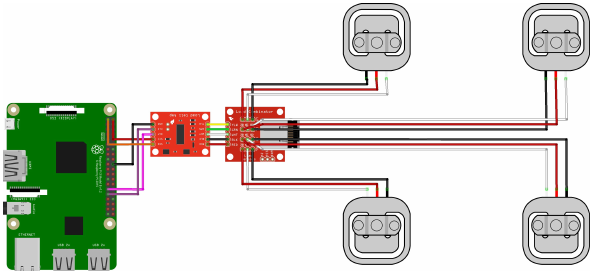
Figure 2. Schematic of electrical connections for the hive weight measurement system: the four load cells are connected in a Wheatstone bridge configuration, and the resulting signal is amplified before being acquired by the Raspberry Pi board.